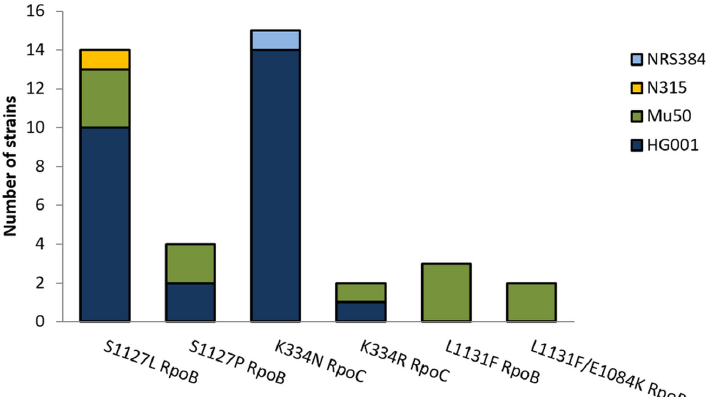
Figure 2. Statistics of amino acid exchanges identified in RpoB and RpoC in 40 CorA-resistant S. aureus mutants with different strain and resistance backgrounds ( S. aureus HG001, N315, Mu50, and NRS384). and